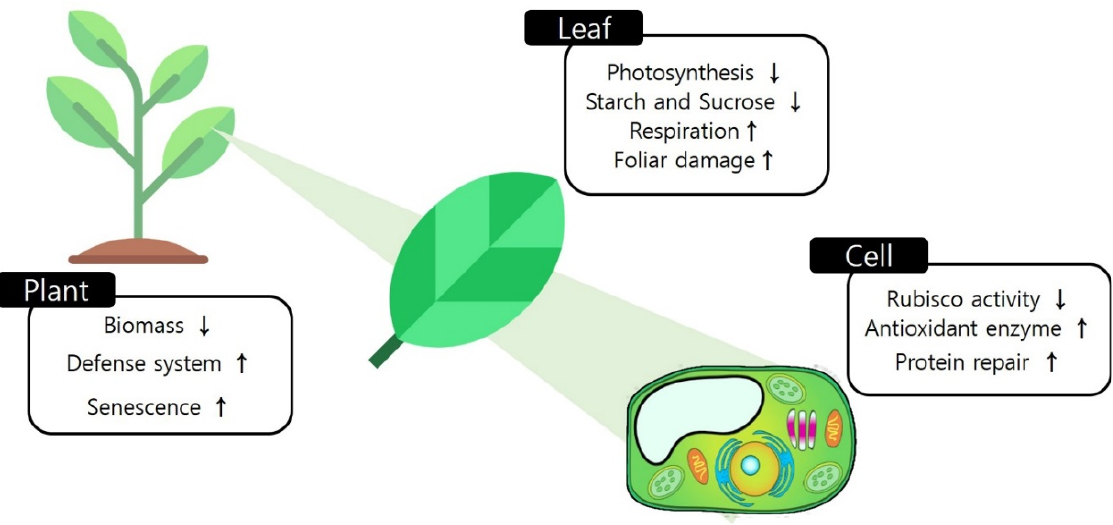
Figure 4. Plant changes caused by elevated O 3 at the plant, foliar, and cellular levels. Figure modified from Ainsworth et al. [5].